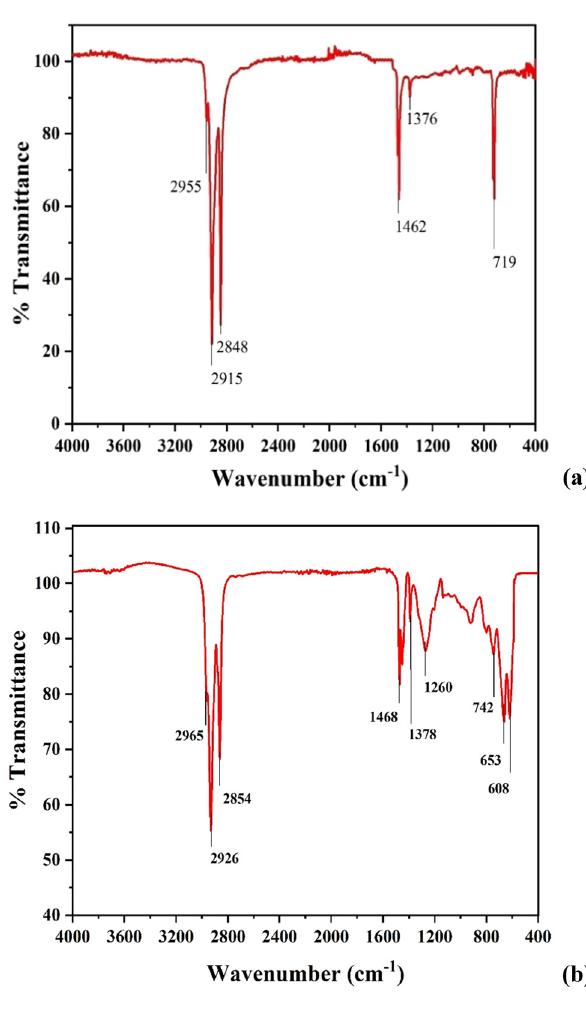
Figure 5: ( a ) FTIR spectrum of LDPE - para ffi n solution before co - chlorination ( 10% LDPE concentration ) ; ( b ) FTIR spectrum of LDPE - para ffi n solution post co - chlorination ( 130°C, chlorine fl ow rate 350 mL · min − 1 , 10% LDPE concentration, and 400 rpm )